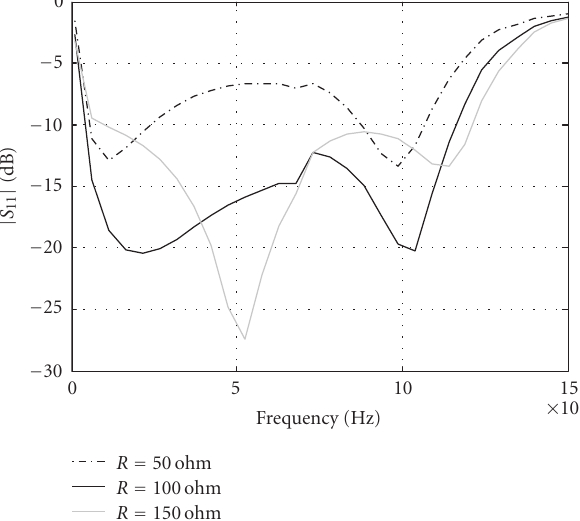
optimal position of the rectangular slot is achieved. Figure 4 shows the e ff ect of varying K .